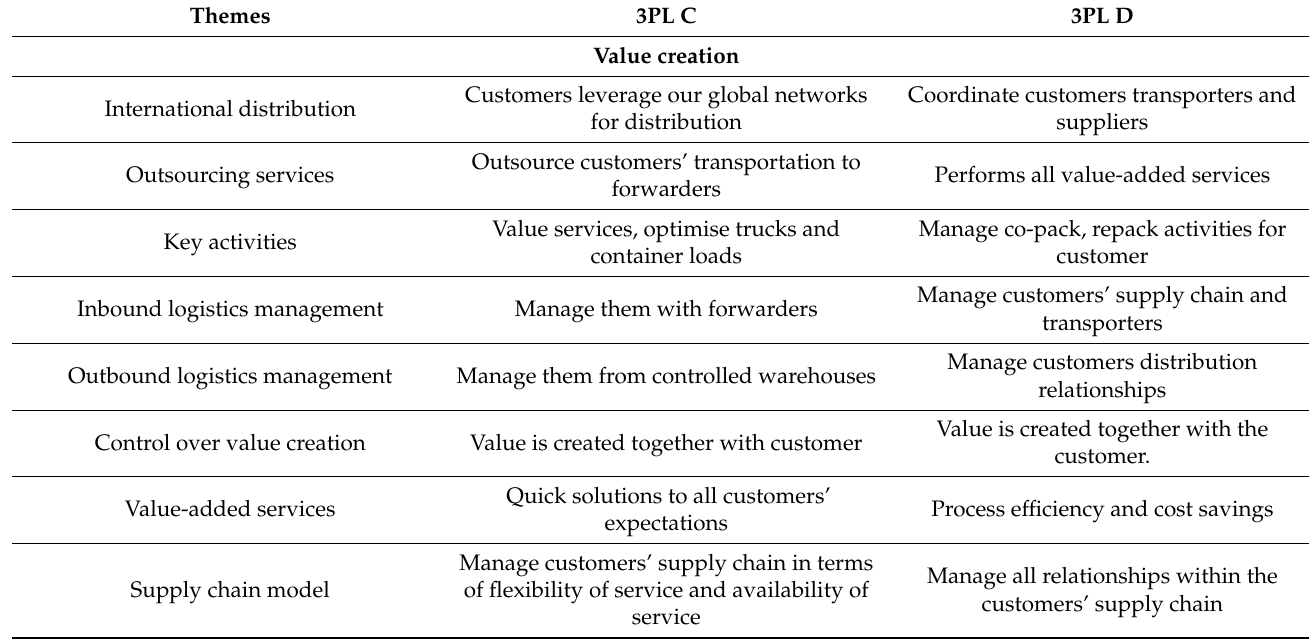
Table 3. Comparative analysis of 3PL